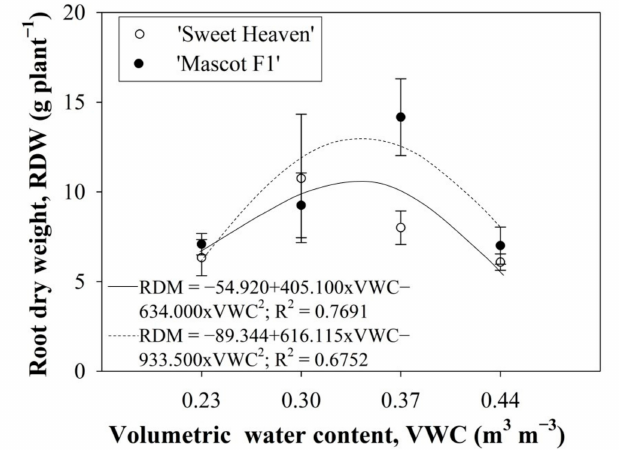
Figure 2. Root dry weight of two cherry tomato cultivars in response to increasing volumetric